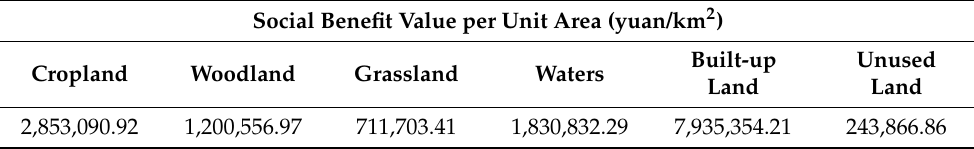
Table 2. The value of social benefits per unit area of the Yellow River Basin from 1995 to